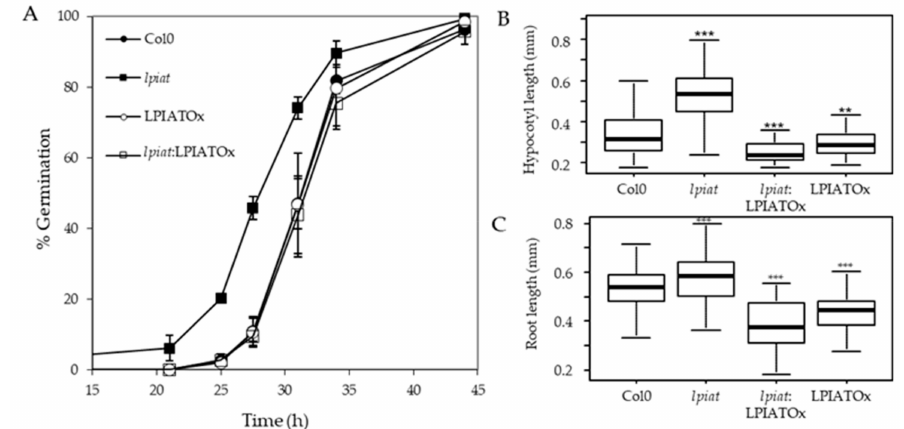
Figure 6. Germination and growth phenotype. ( A ), Seed germination in Col0, lpiat, LPIATOx and lpiat: LPIATOx lines. After 3 days stratification, seeds were germinated on 1 / 2 MS medium, 0.8% agar and 1% Sucrose. About 100 seeds were sowed by plates. % germination was estimated by plates as judged by radical extrusion. Values are means ± SD ( n = 3). ( B ), Hypocotyl length from 3-day-old dark-grown seedlings from wild-type and the indicated LPIAT mutant lines. Seeds were germinated and grown in the dark for 3 days on 1 / 2 MS medium, 0.8% agar and 1% Sucrose. ( C ), Primary roots were measured after 3 days. Values are means ± SD ( n = 60) from one of three independent experiments that gave similar results. Wilcoxon’s test comparisons between altered- LPIAT expression level mutants and the wild type were performed. ***, p -value was < 0.005; **, p -value was <